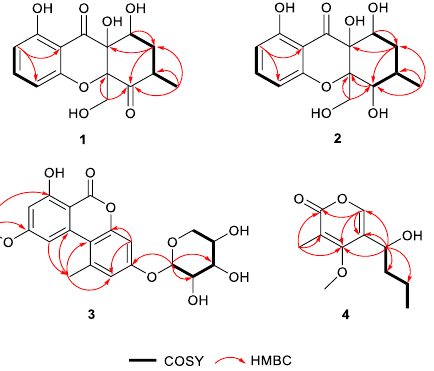
Figure 2. Key 1 H- 1 H COSY and HMBC correlations of compounds 1 – 4 .